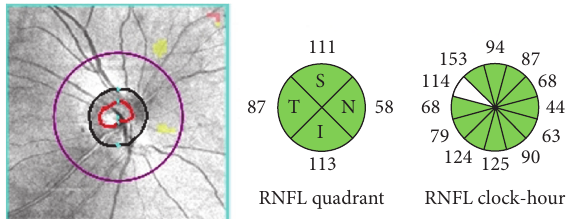
Figure 2: Example of the pRNFL (peripapillary retinal nerve fiber layer) of optical coherence tomography scans showing the area with a radius of 1.73 mm involving the concentric center of the optic disc. Theareawasdividedintofourquadrants(superior[S],temporal[T], inferior [I], and nasal [N]) and 12 clockwise sectors of the right